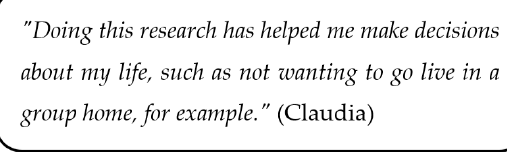
Figure 5. Co-researcher’s opinion 10.